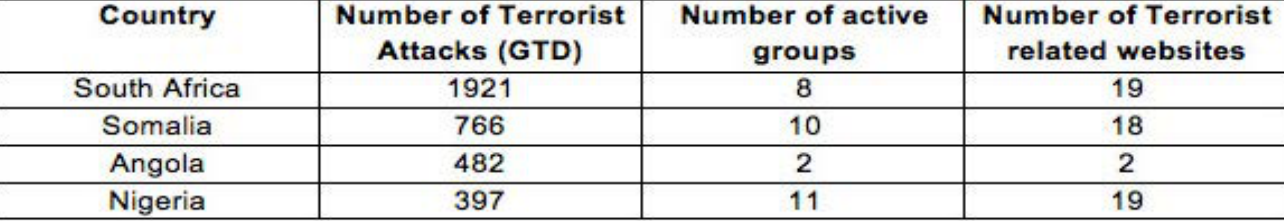
Figure 5: Country, mapped to number of terrorist attacks, groups and